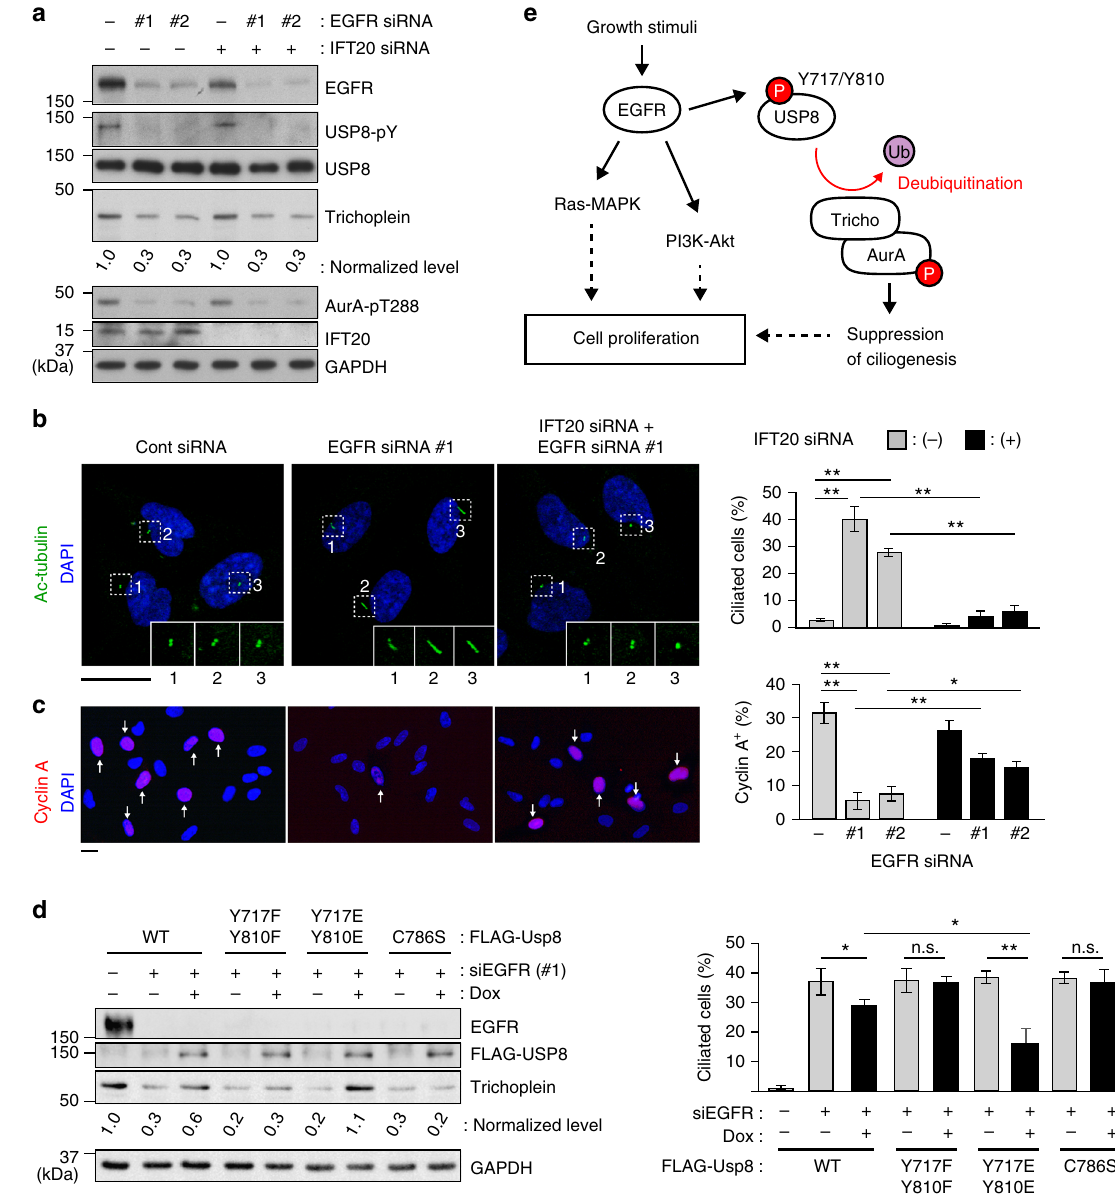
Fig. 8 EGFR contributes cell cycle progression through USP8-trihocplein pathway-mediated cilia suppression. a – c Twenty-four hours after transfection with control or IFT20 siRNA, RPE1 cells were further transfected with control or EGFR siRNA (#1 or #2) and then cultured for 48 h in normal medium (10% FBS). The cells were analyzed by immunoblotting with indicated antibodies ( a ), and immuno fl uorescence staining with anti-acetylated-tubulin and anti- cyclin A to evaluate percentages of ciliated cell ( b ) and cyclin A-positive cell ( c ), respectively. Scale bars, 20 μ m. d TetOn-RPE1 FLAG-USP8 (WT, Y717F/ Y810F, Y717E/Y810E, C786S) cells were transfected with control or EGFR siRNA (#1) and then cultured for 48 h in the presence or absence of Dox (10 ng ml − 1 ). Immunoblotting analysis with indicated antibodies (left) and percentages of ciliated cell (right) are shown. e Proposed model: normalized intensities of trichoplein/GAPDH in a and d are shown as mean from three independent biological replicates. Graphs represent mean ± SD from three independent experiments ( n > 200 each). ** p < 0.01, *0.01 < p < 0.05, n.s. not signi fi cant, two-tailed unpaired student ’ s t